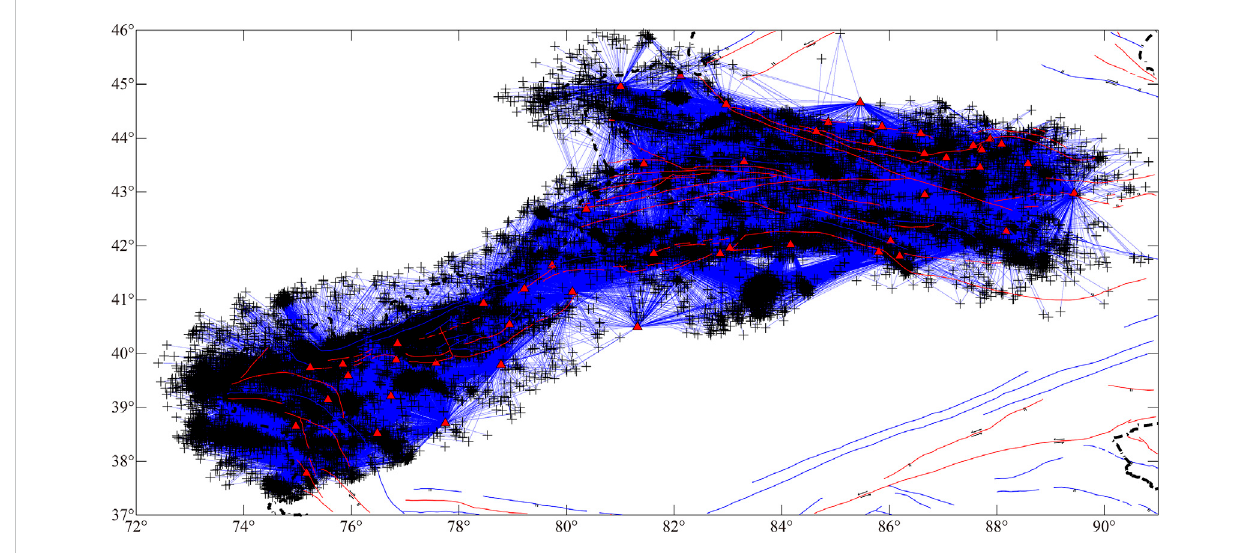
FIGURE 2 Distribution of seismic observation stations (red triangles), events (+), and rays in the Tianshan tectonic belt (TTB).